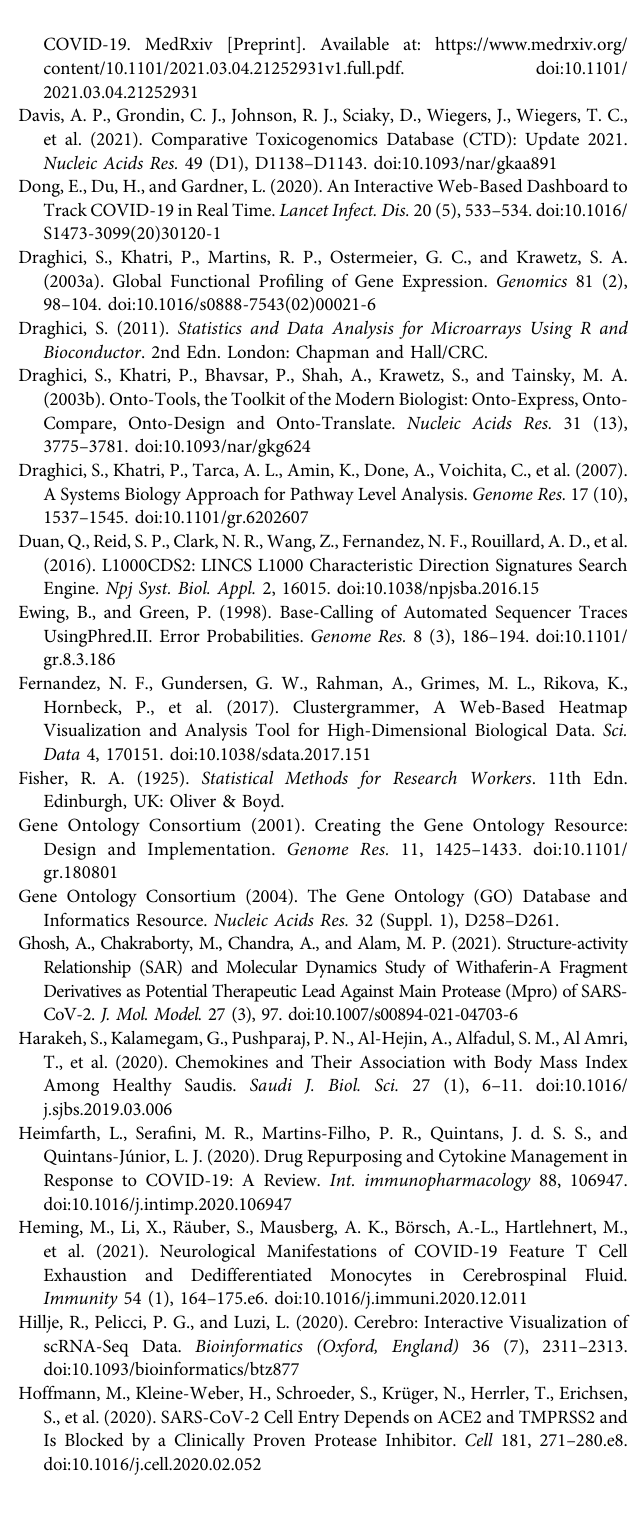
Supplementary Figure S7 | GSEA Preranked analysis was performed to decipher the potential gene signatures differentially regulated (Combined,